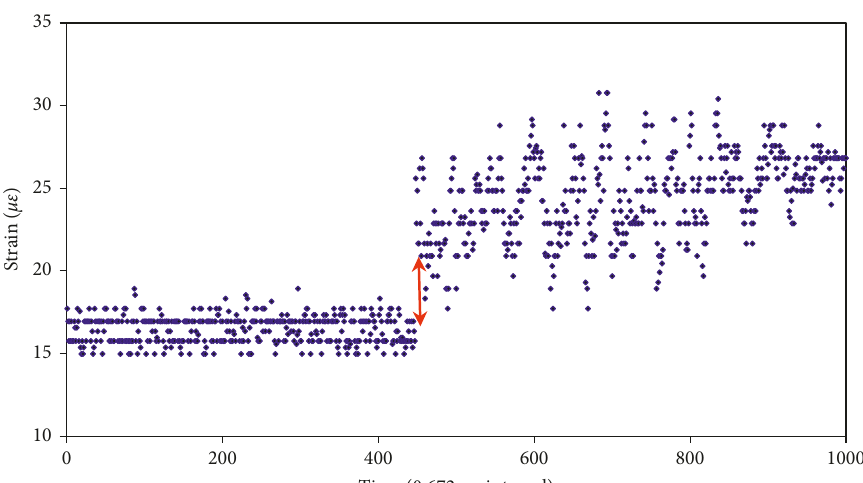
Figure 23: Window